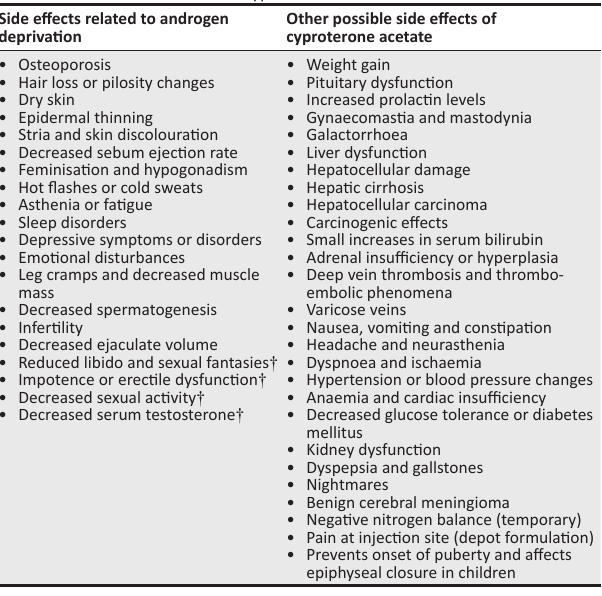
TABLE 1: Possible side effects of cyproterone